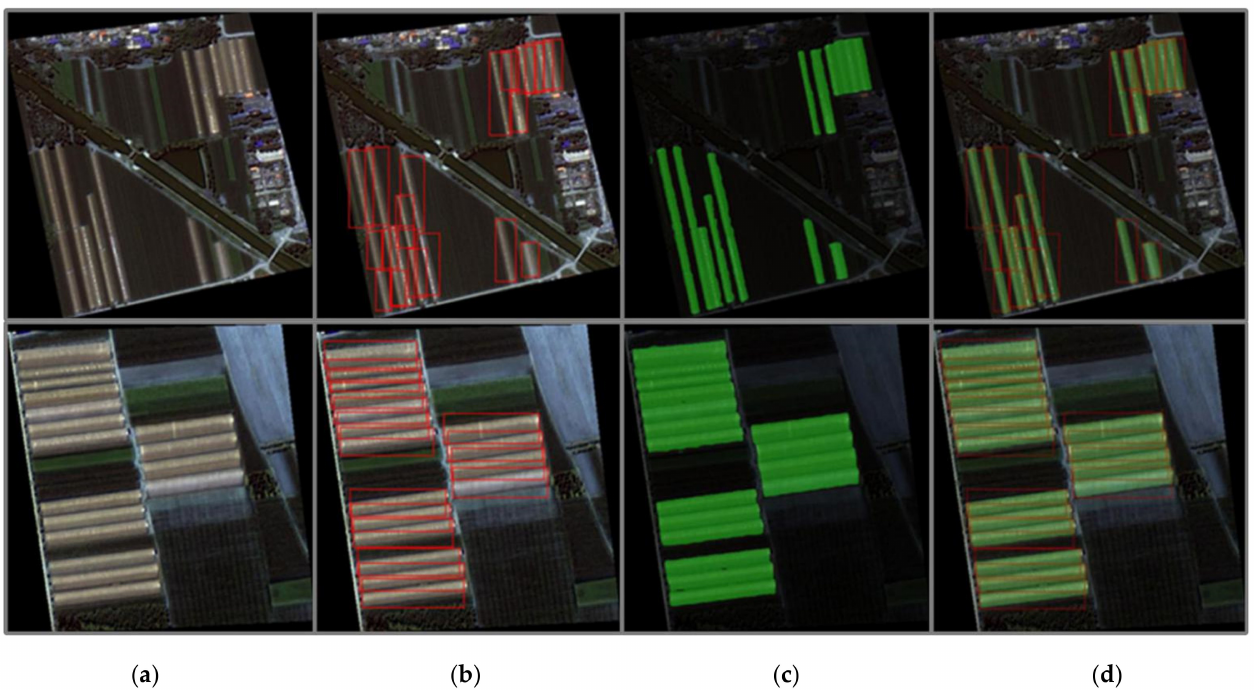
Figure 11. Extraction results of greenhouse for concentrated distribution (the first line) and scattered distribution (the second line). ( a ): input ( b ): object-based result ( c ): pixel-based result ( d ): final